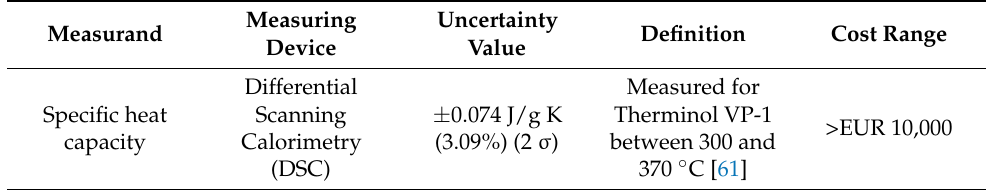
Table 5. Measurand, measuring device, measuring uncertainty and approximate cost range for HTF Sample Laboratory Analysis.